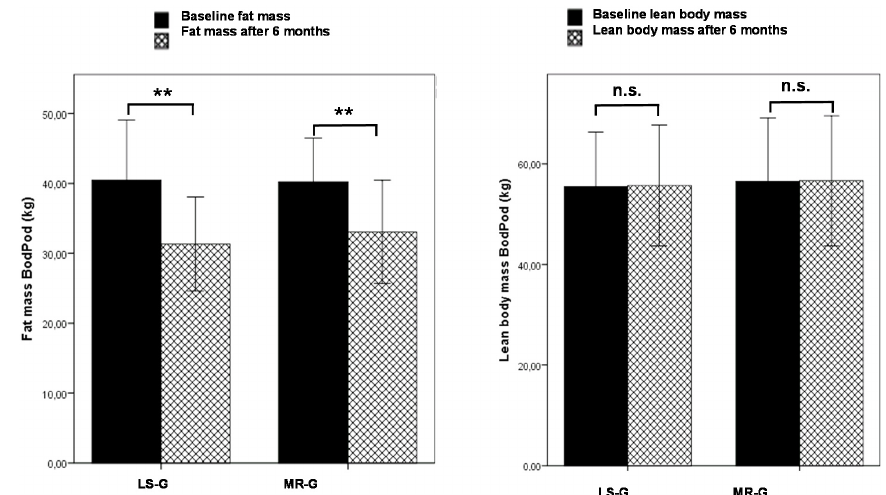
Figure 1. Changes in fat mass (PodBod) and lean body mass (PodBod) after six months by either lifestyle changes (LS ‐ G) or a meal replacement regimen (MR ‐ G); black bar, baseline values; grey hatched bars, post ‐ interventional values after six months. (Error bars: ±1 standard deviation; *, p < 0.05; **, p < 0.01, n.s., not significant). Nutrients 2015 , 7 , page–page